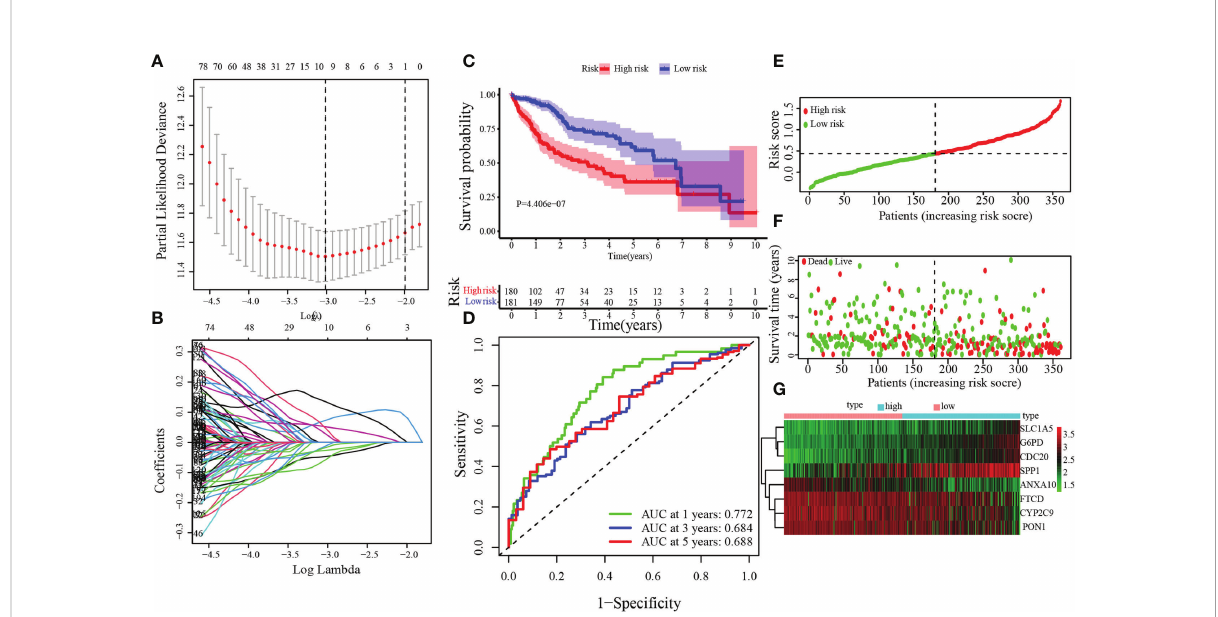
FIGURE 4 Establishment of the MARCH ligase signature according to the training set. (A, B) LASSO Cox regression analysis. (C) Kaplan – Meier analysis between risk score-de fi ned groups. (D) Time-dependent ROC curve of risk score. (E) Risk score distribution. (F) Survival status heatmap. (G) The expression pro fi le heatmap of eight